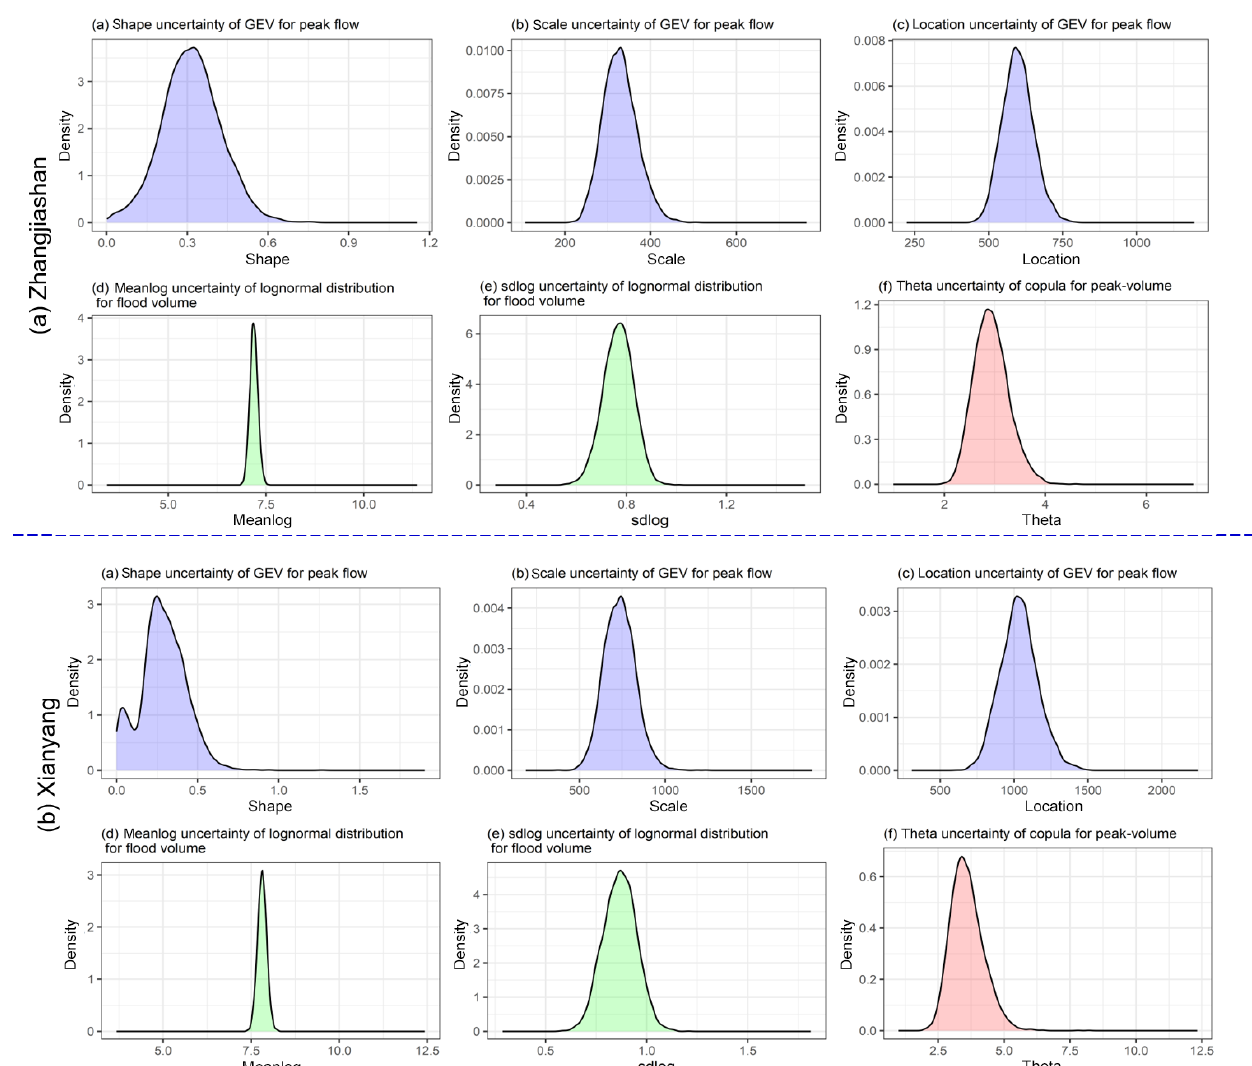
Figure 3. Probabilistic features for parameters in marginal distributions and copula: for both the Xianyang and Zhangjiashan stations, the GEV (parameters include shape, scale, and location) function would be employed to quantify the distribution of flood peak, while the lognormal distribution (parameters denoted as meanlog and sdlog) is applied for flood volume. The Gumbel and Joe copulas (parameter denoted as theta) would be, respectively, adopted to model the dependence between flood peak and volume at the Zhangjiashan and Xianyang